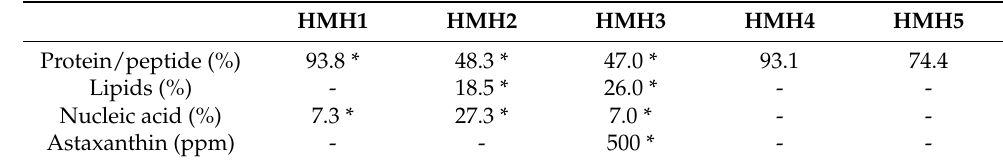
Table 1. Chemical composition of the different herring milt hydrolysates